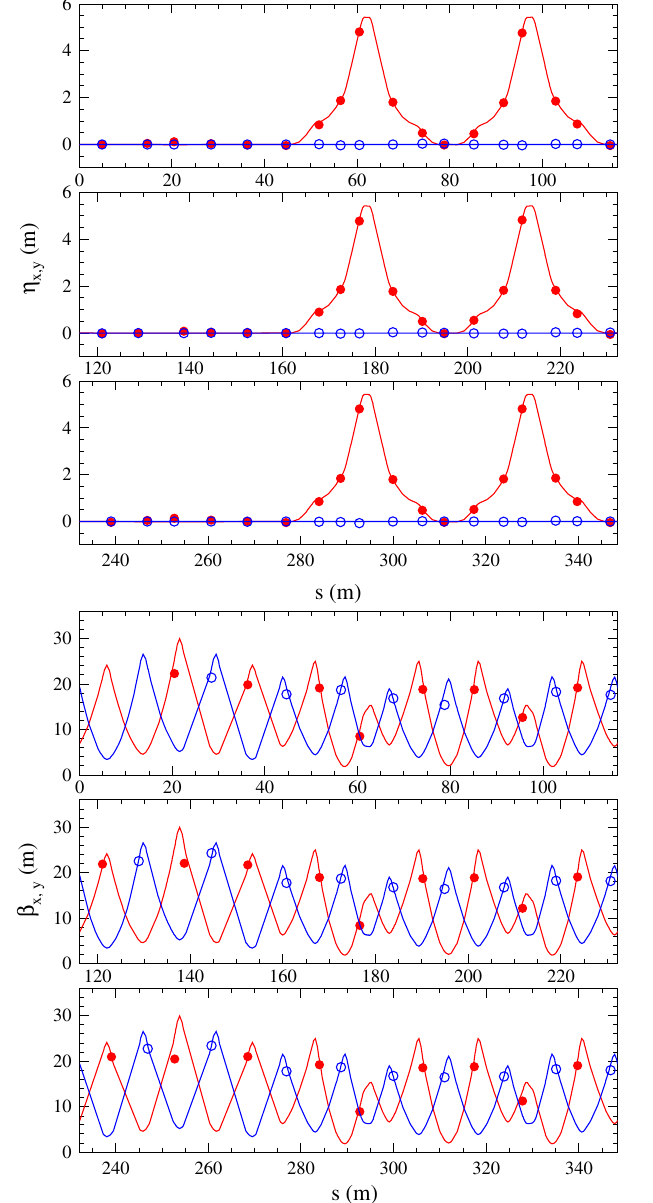
FIG. 8. (Color) Corrected dispersion (upper) and betatron am- plitude (lower) functions observed in the beam storage mode, where closed red circles are the horizontal ones, open blue circles the vertical ones, and solid curves the